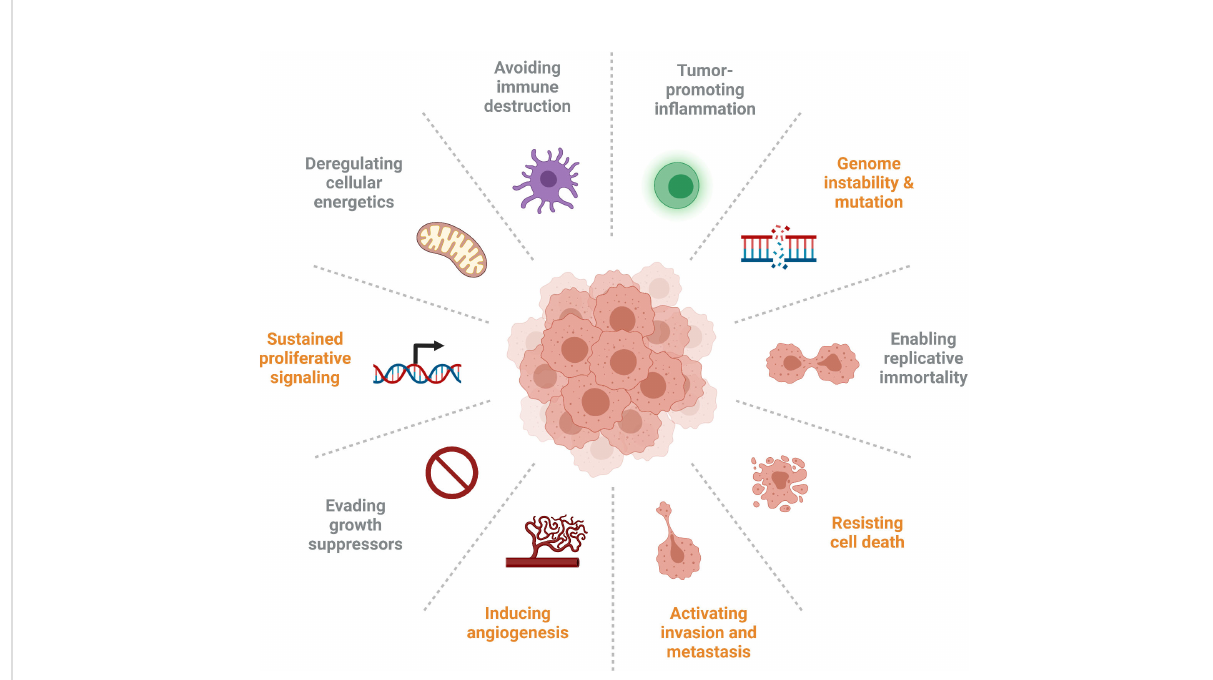
FIGURE 7 Several of the Hallmarks of Cancer are impacted by aberrant expression of IGFBP5 (identi fi ed in orange), which affects cell proliferation and survival, inhibits angiogenesis, enables adhesion of metastatic cells, and is prone to copy number variation in clinical